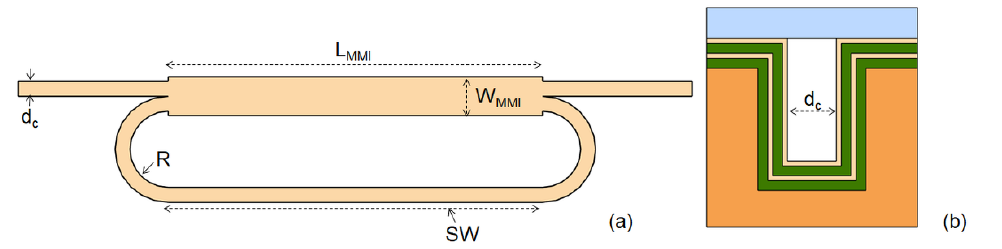
Figure 1. ( a ) Schematic layout of the planar optofluidic ring resonator based on h-ARROW. ( b ) Schematic cross section of an h-ARROW.